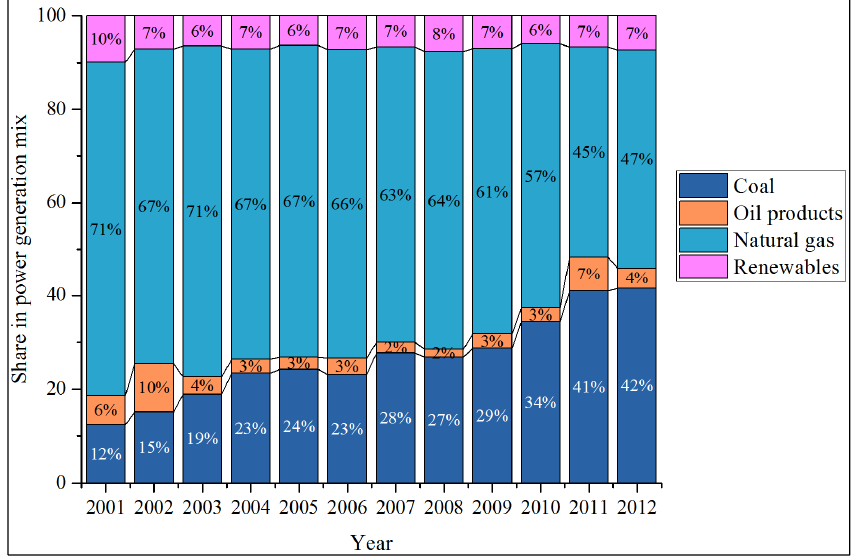
Figure 14. Malaysia: power generation